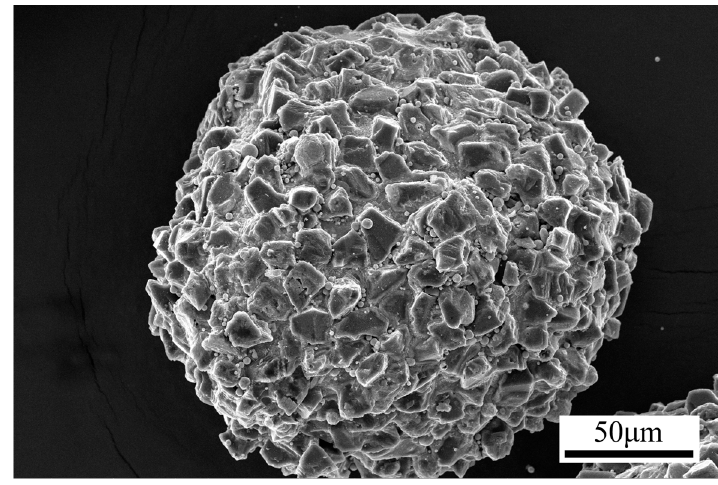
Figure 2. SEM image of CBN magnetic abrasive.